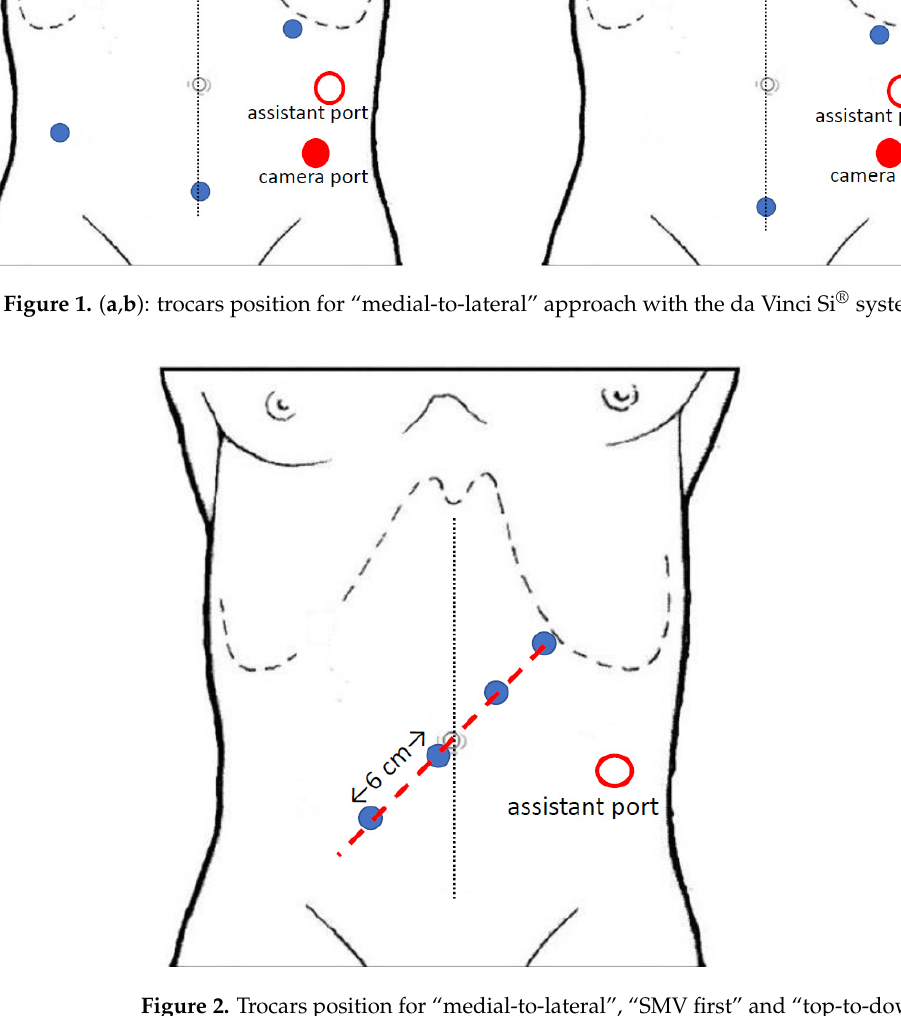
Figure 2. Trocars position for “medial-to-lateral”, “SMV first” and “top-to-down” approach with the da Vinci Xi ® system.